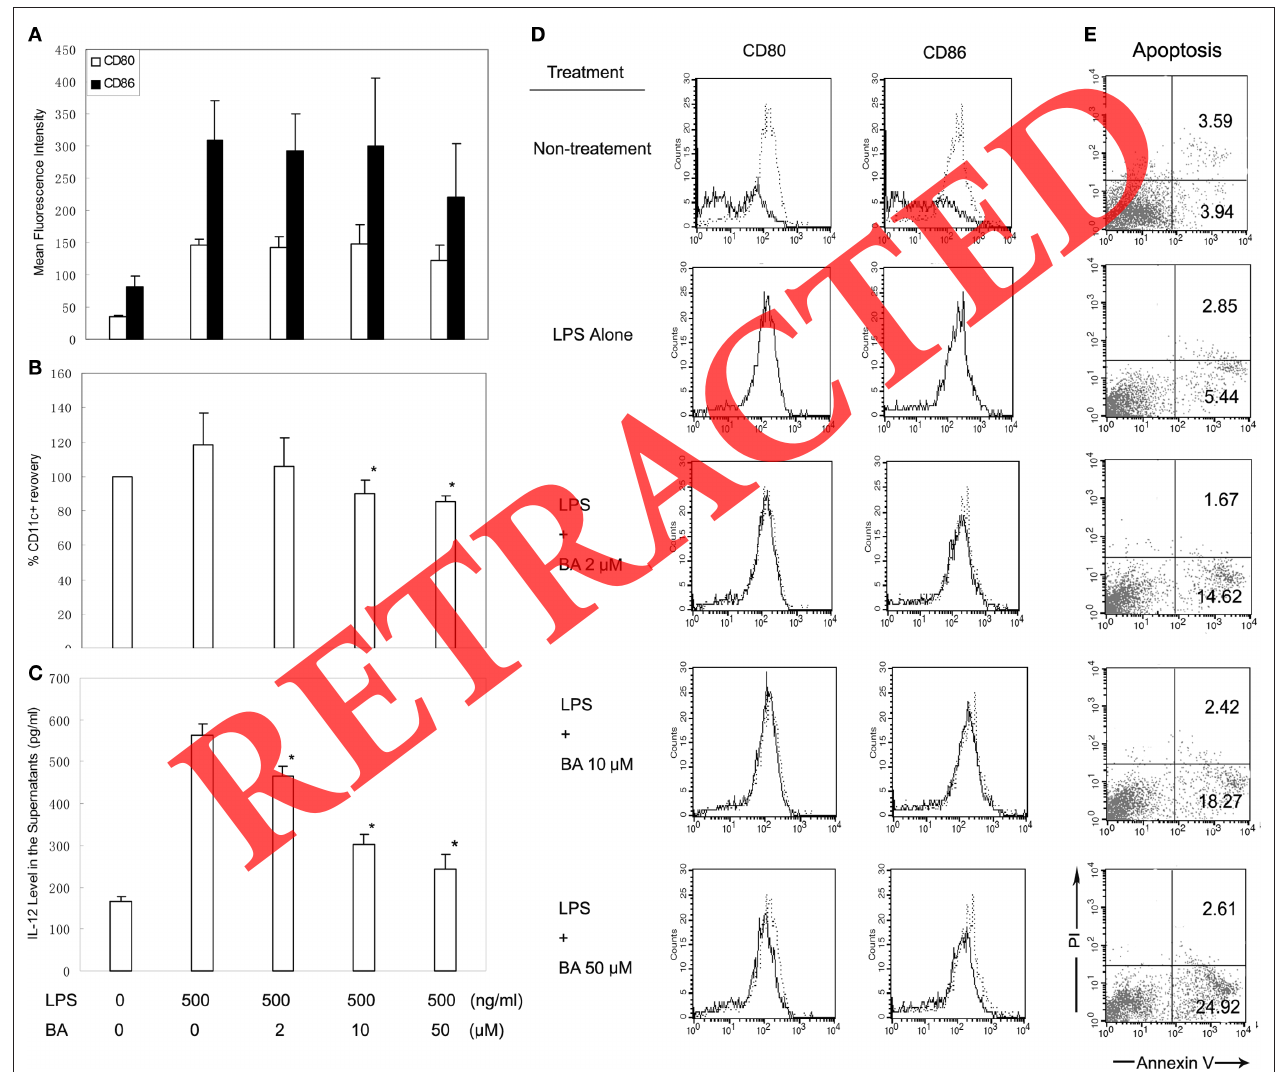
Figure 2 | effects of BA on bone marrow-derived DC (BMDC) maturation and apoptosis. (A) Effects of BA on the up-regulation of CD80/CD86 expressions on day-6 BMDCs in response to LPS stimulation. (B) Effect of BA on numbers of viable CD11c + cells recovered on day 6 of culture BM cells (expressed as percentages of total viable number of CD11c + cells in non- treatment control). (C) Effect of BA on the release of IL-12 into supernatants.